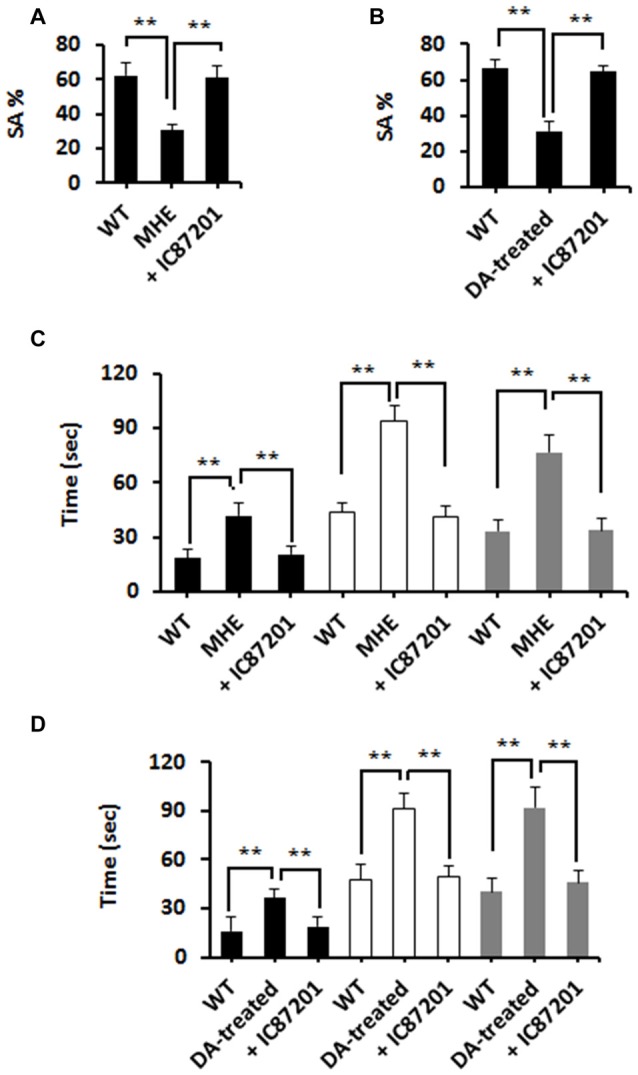
DA triggers PSD95–nNOS interaction in vivo. (A) Y-maze test of MHE rats (n = 26) with or without IC87201 administration (SA%). (B) Y-maze test of DA-treated rats (n = 20) with or without IC87201 administration. (C) Water-finding task of MHE rats with or without IC87201 administration. (D) Water-finding task of DA-treated rats with or without IC87201 administration. Data are shown as mean ± SD. **P < 0.01.